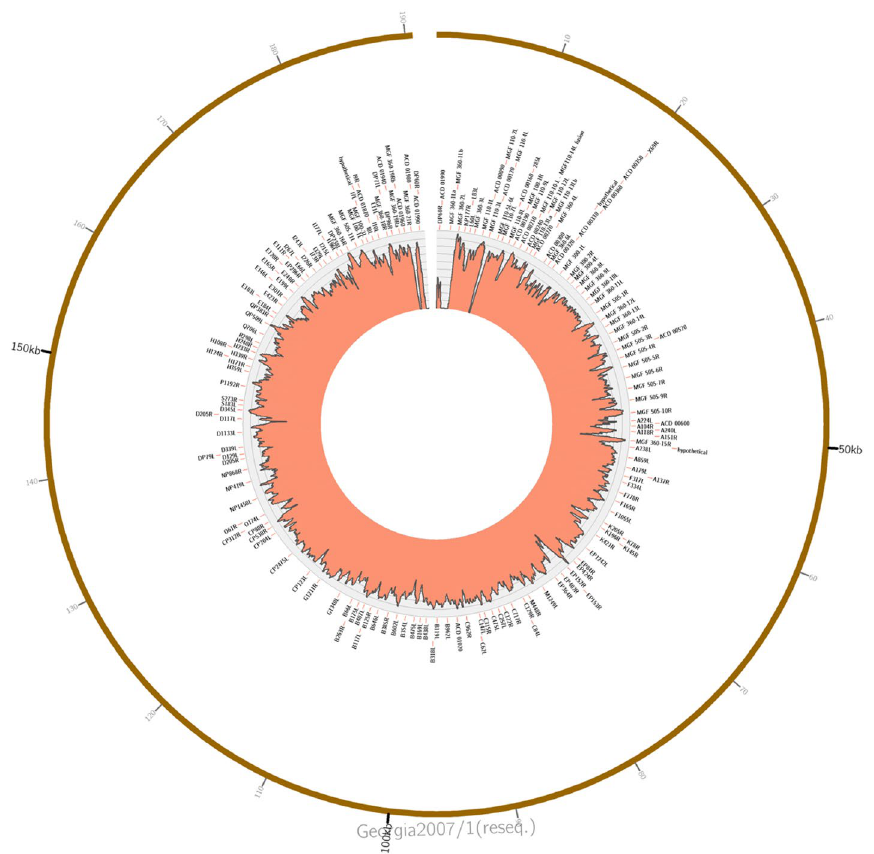
Figure 2. Circos plot representing the mapping of reads from the Tanzania/Rukwa/2017/1 genome to the recently corrected Georgia 2007/1 (FR682468.2) strain. The histogram shows log read depth values. The inner wheel gives approximate locations for the open reading